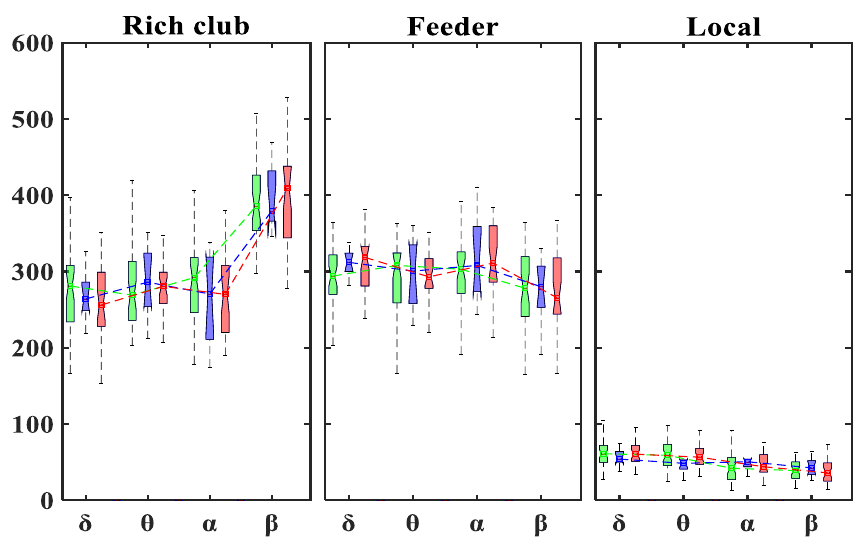
Figure 7. Boxplots displaying the median and interquartile ranges of the number of rich-club connections for each group (TD: green; ADHD I : blue; ADHD C : red) in different frequency bands.